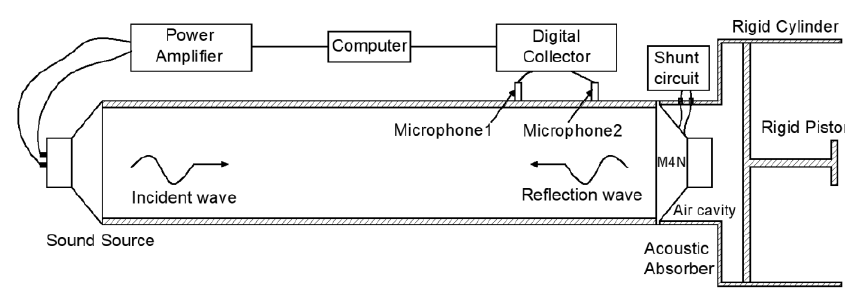
Figure 4. Experimental setup of the SL.